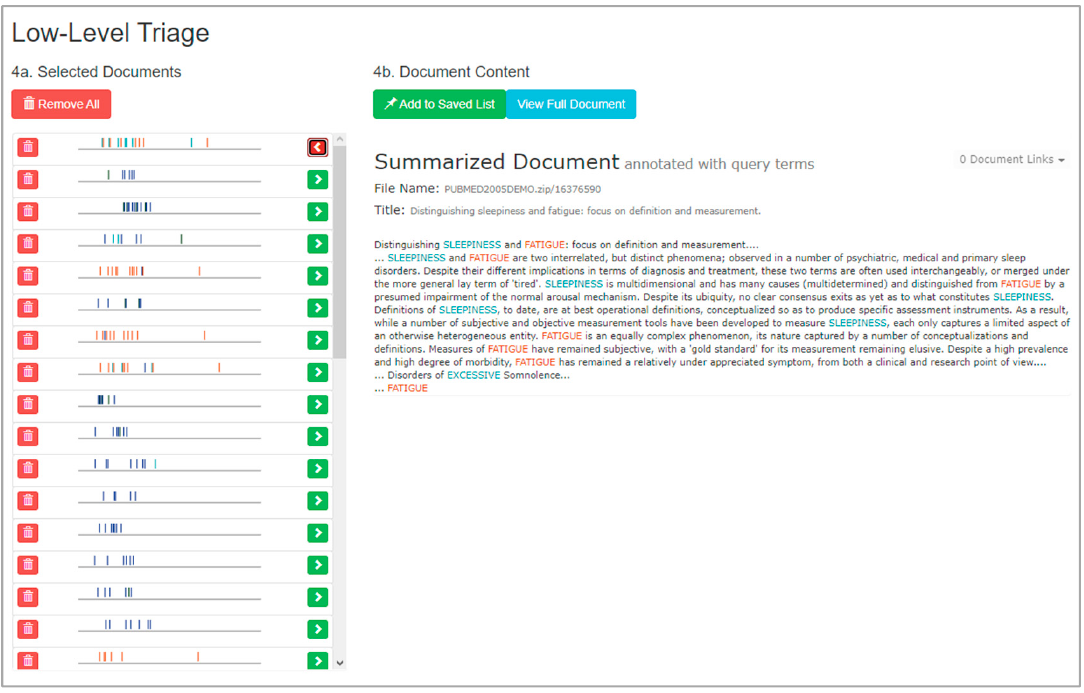
Figure 15. An overview of low-level triage after documents have been added and opened for viewing.